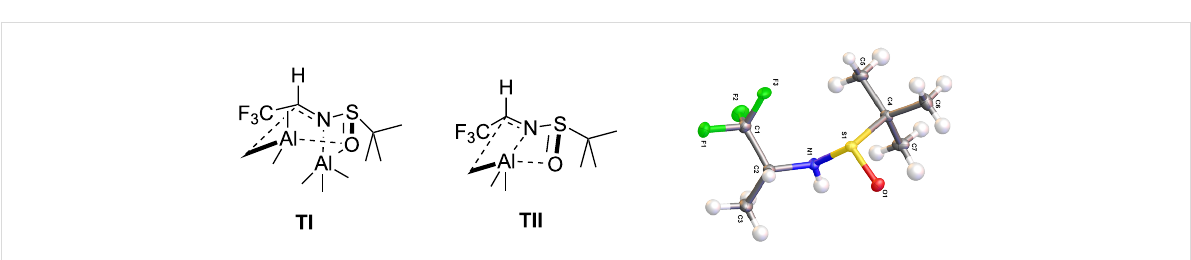
Figure 7: a) Possible transition states TI and TII for the transfer of the methyl moiety from AlMe 3 to the imino moiety. b) X-ray crystal structure analy- sis of the methyl transfer product 10k .